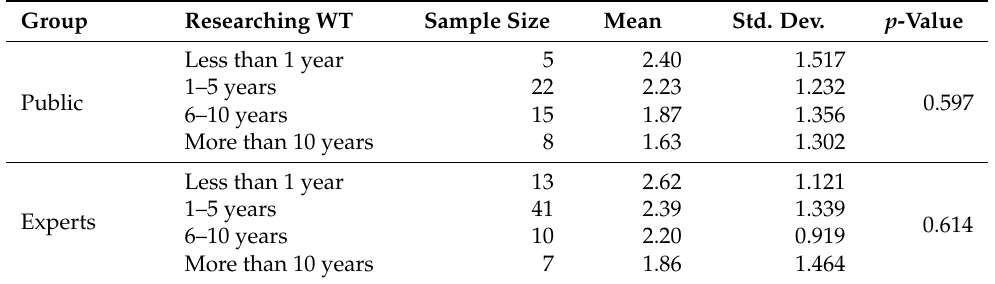
Table 11. Willingness to install a wind turbine in one’s own garden, grouped by duration of research.